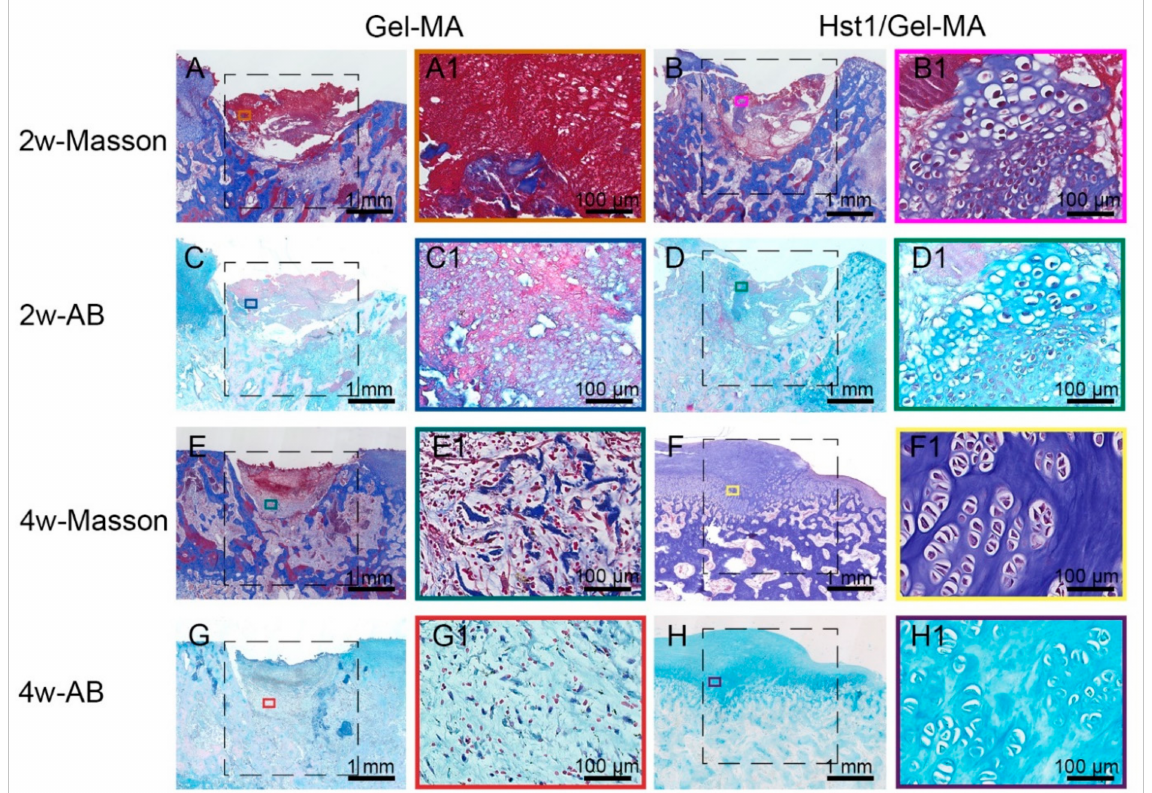
Figure 5. Light micrographs of Alcian blue-stained and Masson’s trichrome-stained tissue sections of repaired osteochondral defects in the Gel-MA and Hst1/Gel-MA groups. Masson’s trichrome staining at 2 weeks ( A , B ) and 4 weeks ( E , F ); Alcian blue staining at 2 weeks ( C , D ) and 4 weeks ( G , H ). The dotted square area indicates the original defect area (3 mm × 3 mm). Scale bar = 1 mm in A – H ; Scale bar = 100 µ m in A1 – H1